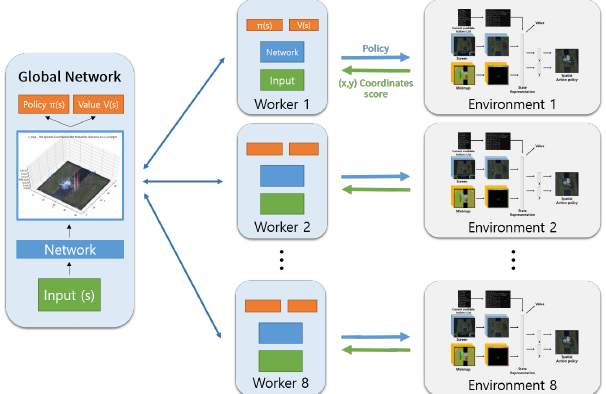
Figure 3. Overall diagram of A3C architecture in the StarCraft II training